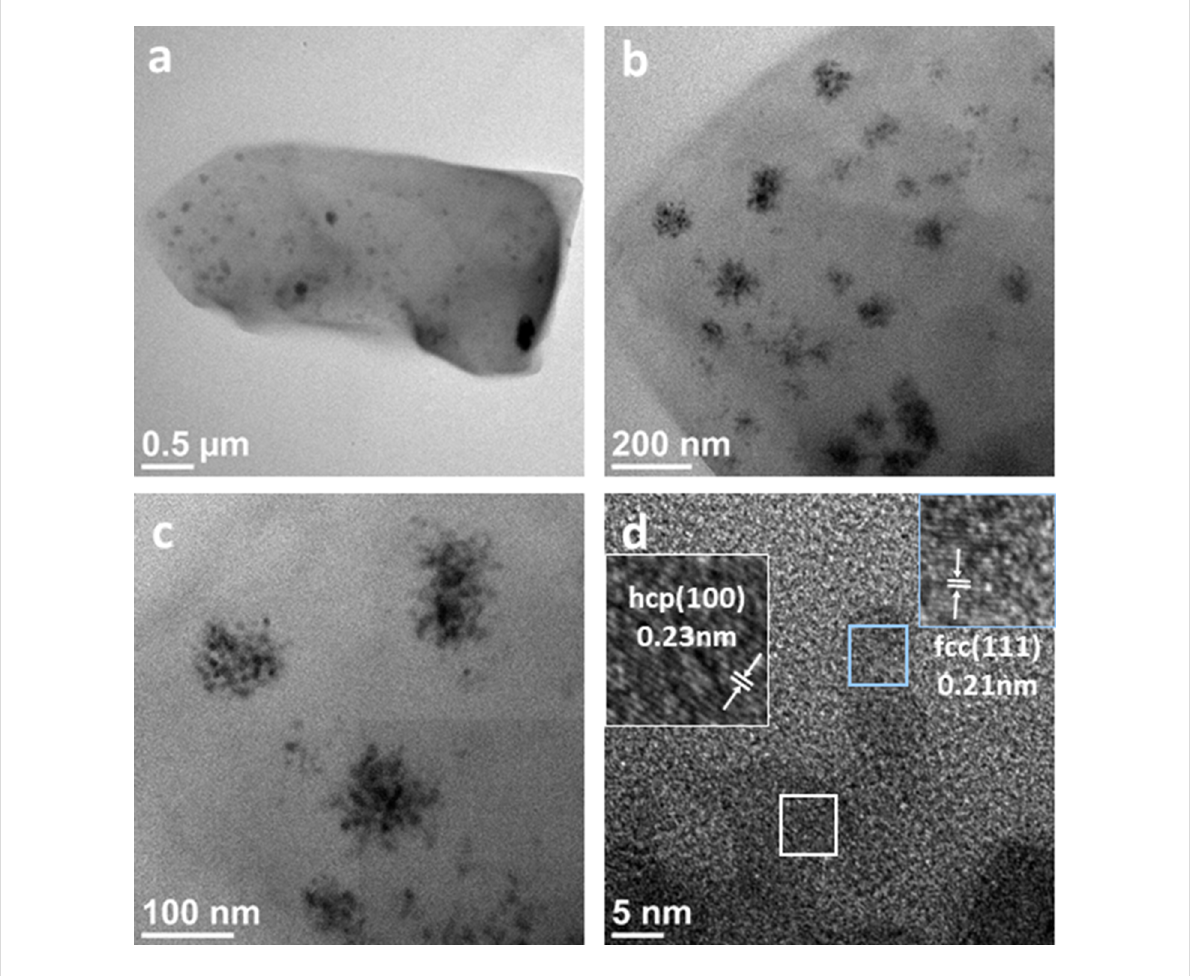
Figure 2: TEM images of Ni/CTF-1-600-22 showing (a) Ni nanoparticles supported on CTF, (b,c) the aggregation of the primary Ni nanoparticles and (d) the lattice planes of the Ni nanoparticles.